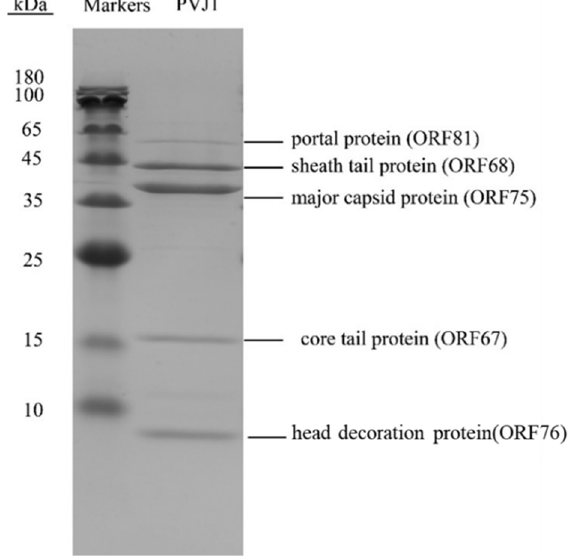
Figure 4. Structural proteins of PVJ1 as revealed by SDS–PAGE. A sample of purified PVJ1 virions was subjected to 12% SDS–PAGE. The gel was stained with Coomassie brilliant blue G250. Gel slices containing protein bands were excised. Proteins in the gel slices were digested with trypsin, and the resulting peptides were analyzed by MALDI–TOF mass spectrometry. The identity of the proteins is shown.